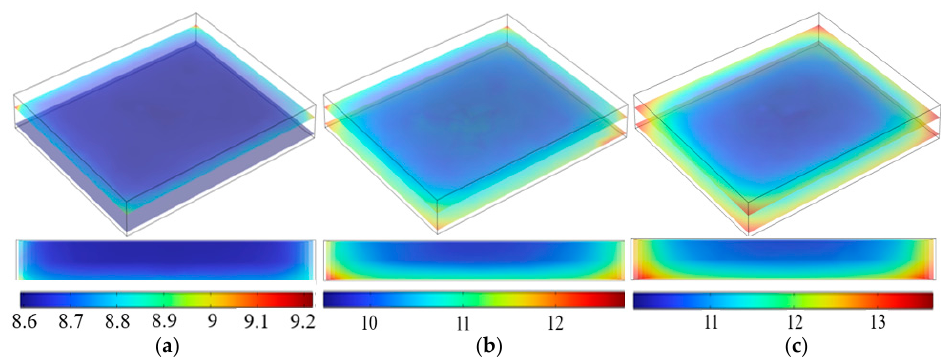
Figure 6. Schematic diagram of the rewetting process (the values in the figure represent the moisture content, unit: %). ( a ) The moisture content and distribution of tobacco strips at 1 s; ( b ) the moisture content and distribution of tobacco strips at 25 s; ( c ) the moisture content and distribution of tobacco strips at 50 s.